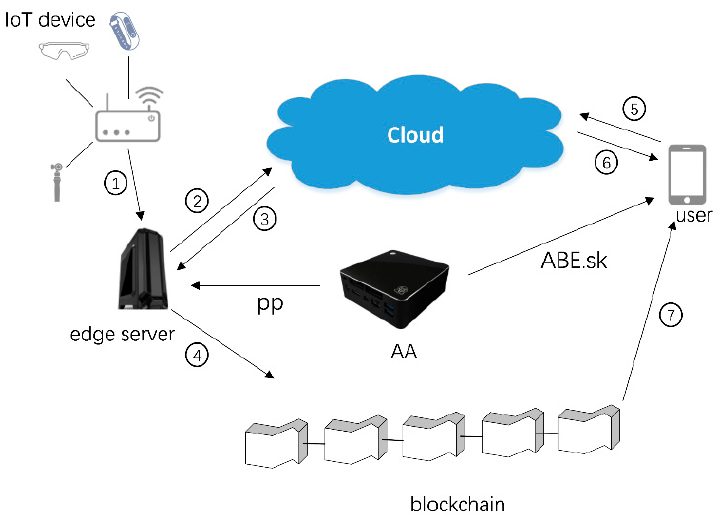
Figure 1. System